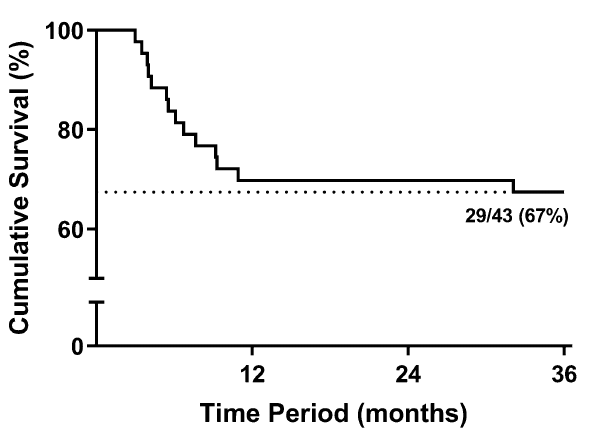
Figure 2. The Kaplan–Meier curve for additional nonsurgical treatment requirement after vitrectomy combined with intraoperative dexamethasone implantation for non-tractional refractory diabetic macular edema. Twenty-nine of 43 (67%) eyes maintained the resolved state for 3 years, and 14 of 43 (33%) eyes required further treatment for diabetic macular edema. Ten of 43 (23%) eyes experienced temporary resolution of macular edema between 1 and 6 months postoperatively, but the macular edema recurred during the follow-up period and underwent additional treatment. Four (9%) subjects did not achieve resolution of macular edema and underwent additional treatment after 3 months